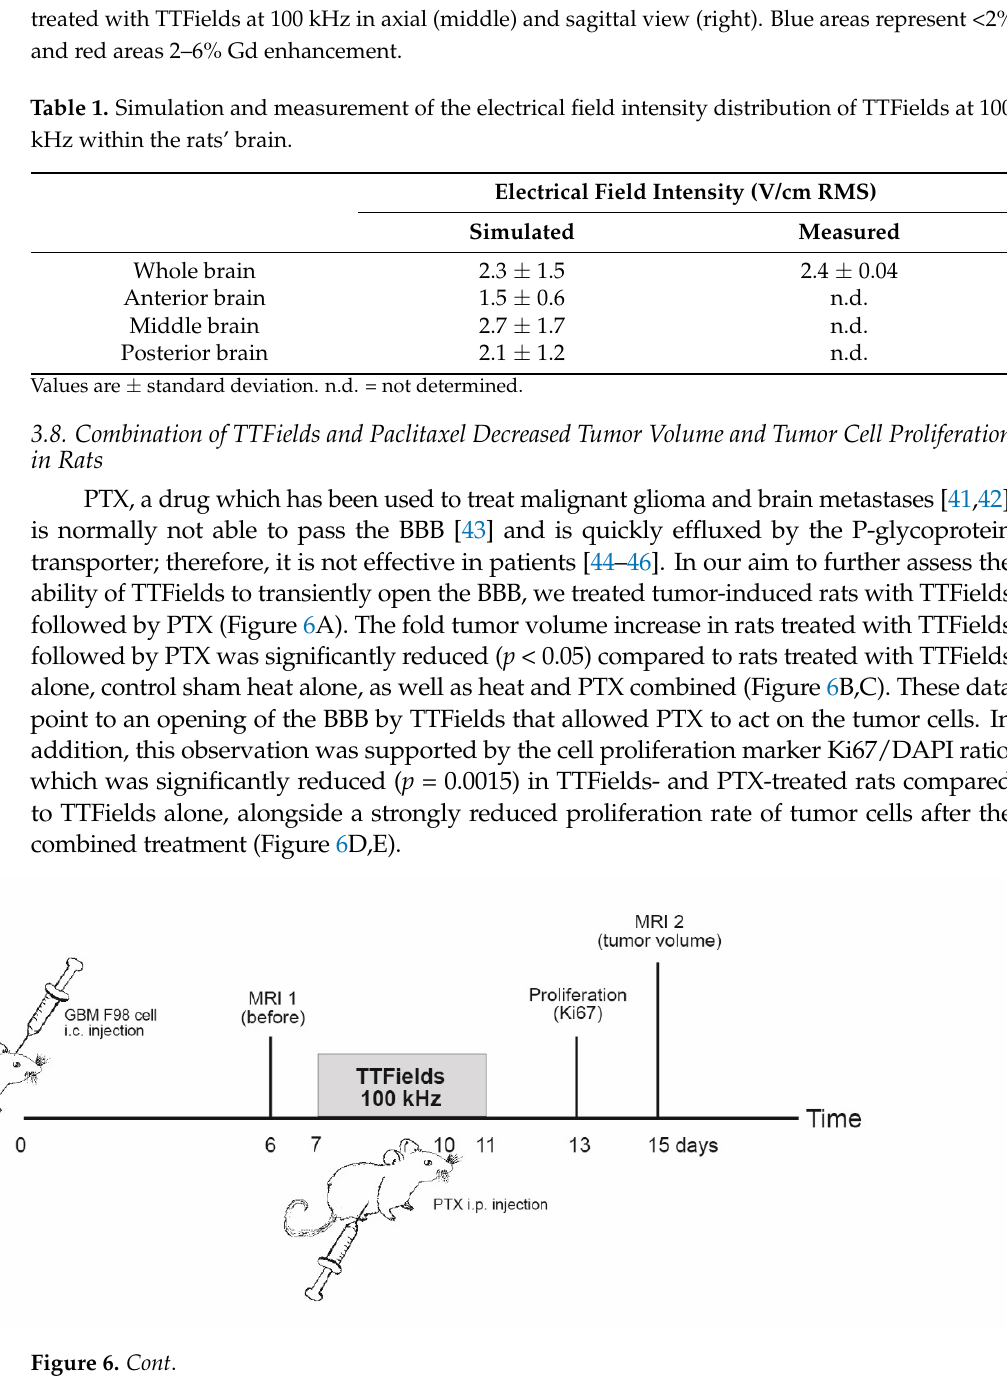
Figure 6. Combined TTFields and PTX treatment of rats. ( A ) Schematic representation of the time course. Rats (seven to eight animals per group) were injected orthotopically with GBM F98 cells. PTX (15 mg/kg) or vehicle were injected intraperitoneally on day 3 of TTFields at 100 kHz. ( B ) MRI scans (upper) and postmortem tissue sections (lower) at day 15 after tumor injection. Arrows indi- cate the tumor boundaries. ( C ) Quantification of the fold tumor volume increase in the different treatment groups. ( D ) Ki67 (red) and DAPI (blue) staining of combined TTFields-PTX treatment in